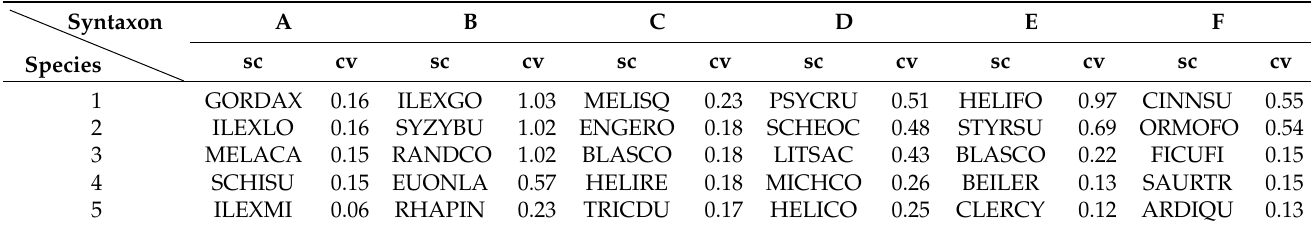
Table 2. The first 5 high values of species for each syntaxon are listed with the species code (sc) and characteristic value